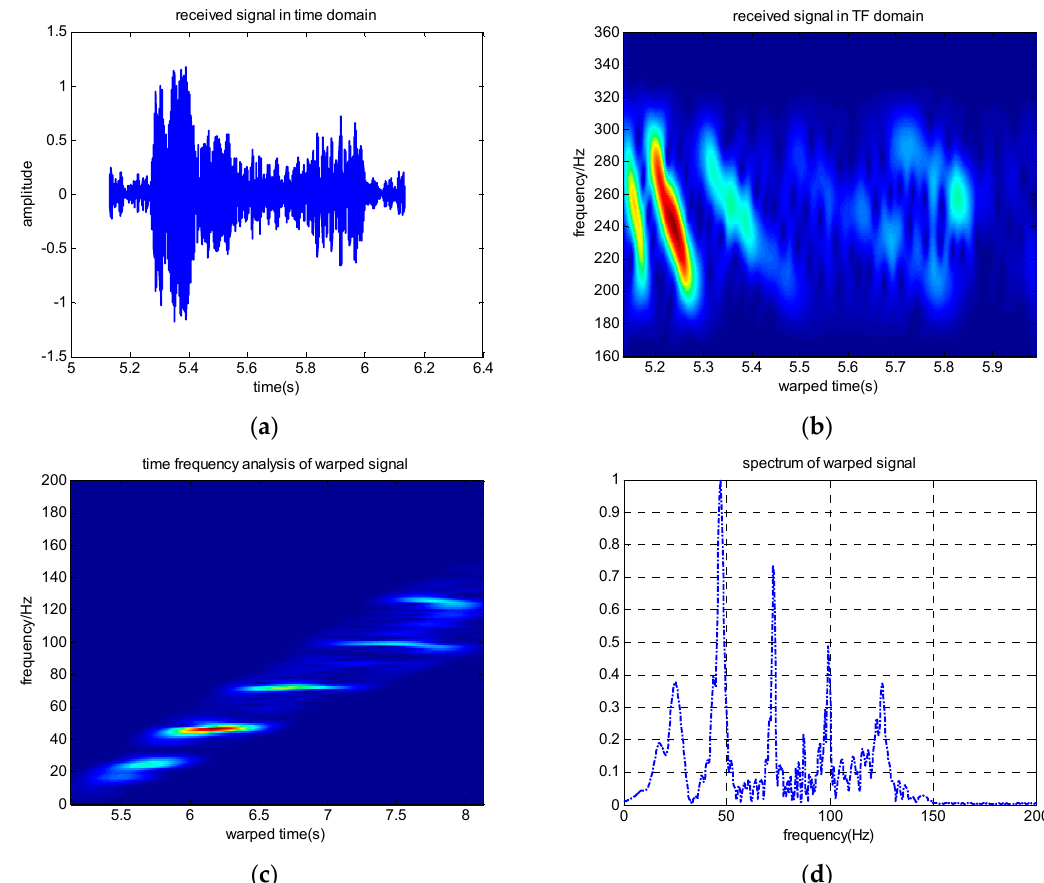
Figure 2. Simulated results. ( a ) Received signal in time domain; ( b ) received signal in the TF domain; ( c ) warped signal in the TF domain; ( d ) spectrogram of the warped signal.